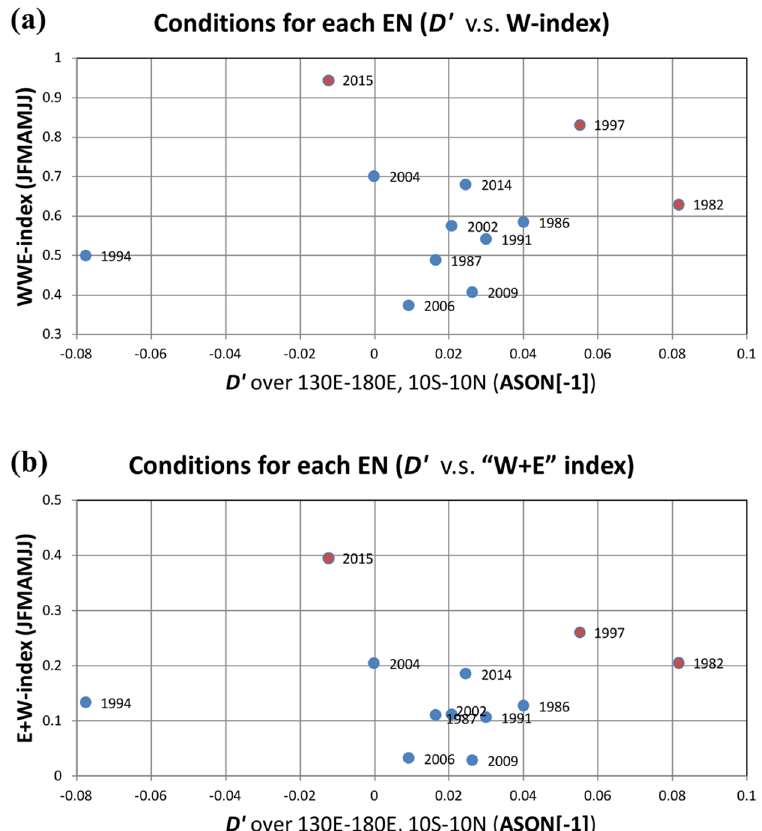
Figure 5. (a) Scatterplot of the Jan–Jul (0) accumulated WWE index and the precursory D ′ signal for each El Niño event during 1979–2015. Here the precursory D ′ signal is estimated by the Aug–Nov( − 1) averaged sea surface height anomaly (a proxy of D ′ ) over the tropical western Pacific (130°E–180°, 10°S–10°N). (b ) same as ( a ) but for the accumulated “W + E” index, which is the summation of the accumulated WWE and accumulated EWE index. It shows that when taking into account the role of easterlies, the spreading between 2015 EN and other ENs revealed by the “W + E” index (Fig. 5b) resembles that revealed by the WWE index alone (Fig. 5a). The specific calculation of the accumulated WWE, EWE, and “W + E” index is introduced in the method section. This figure was generated by the licensed Microsoft